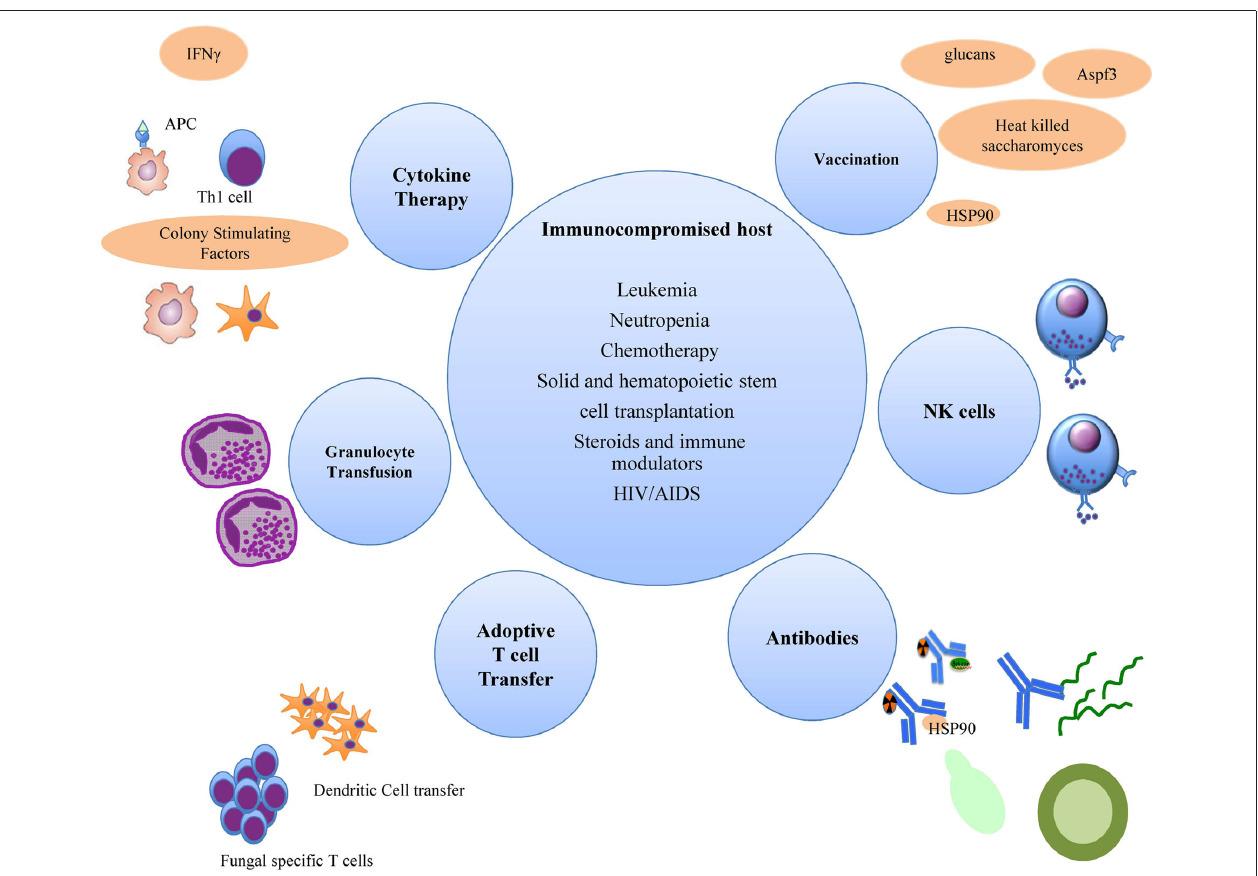
FIGURE 1 | Immune enhancement strategies for invasive fungal infections in immunocompromised